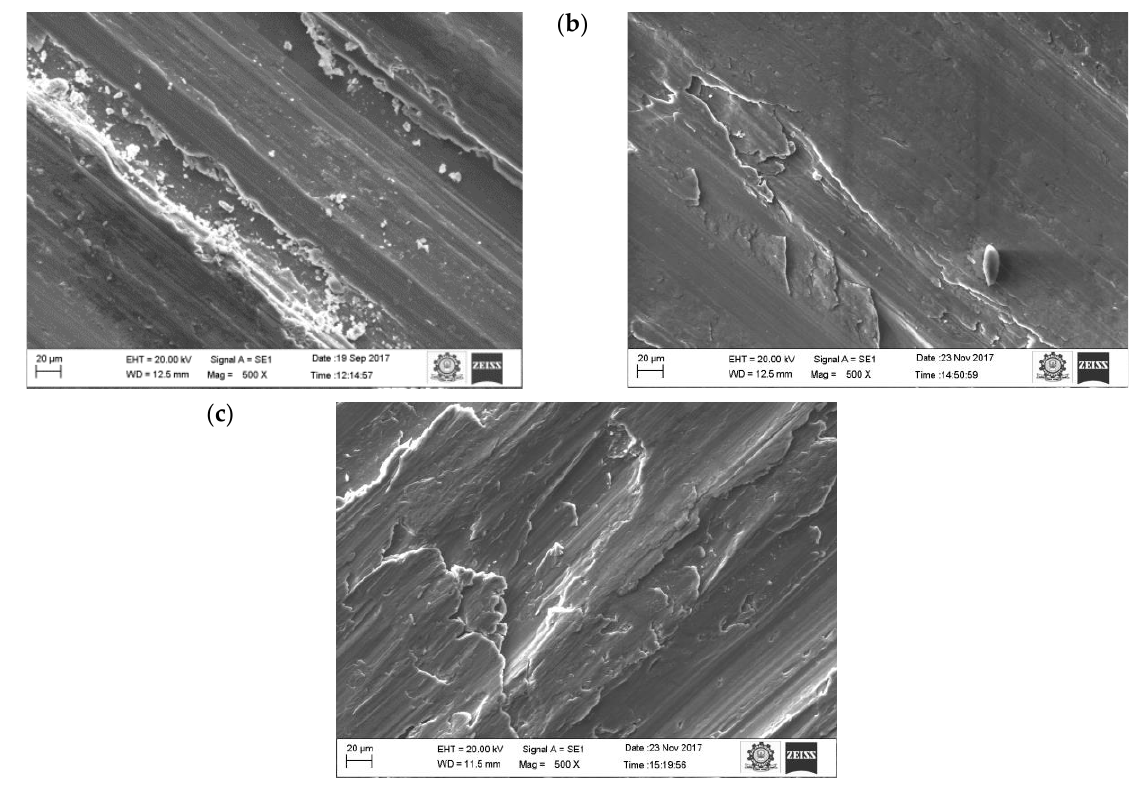
Figure 7. Worn surface morphology (SEM images) of the pure aluminum: ( a ) 0.75 m/s, ( b ) 1.5 m/s ( c ) 2.25 m/s.